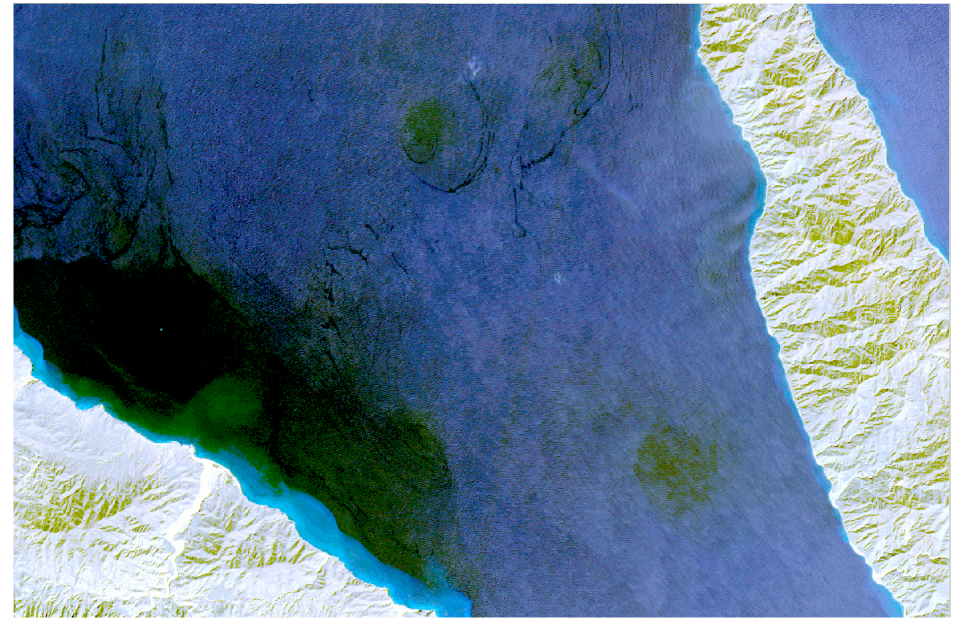
Figure A3. True color composite of the 27 October 2016 image. This scene exhibits distinct blooms of discolored waters (algal blooms).